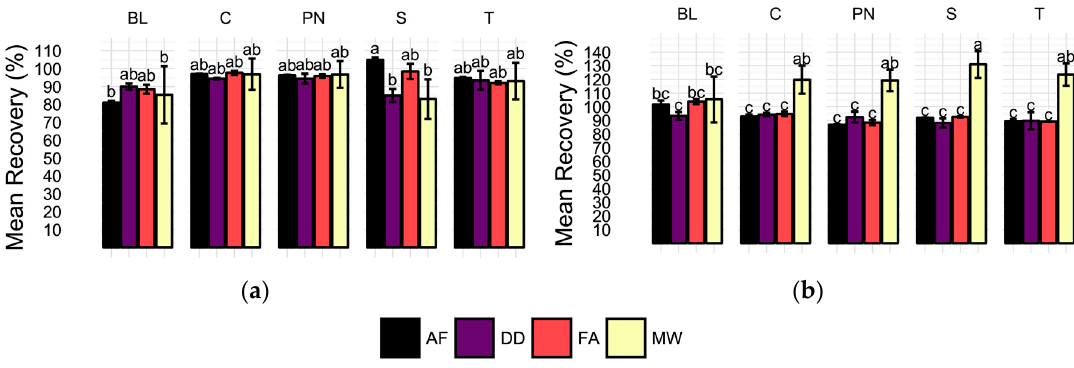
Figure 3. Average ( a ) 65 Cu and ( b ) 206 Pb spike recoveries (%) for each sample type (BL = method blank, C = Chardonnay, PN = Pinot noir, S = Syrah, T =Tempranillo) and preparation method (AF = acidification prior to filtration, DD = direct dilution, FA = filtration prior to acidification, MW = microwave-assisted digestion). Error bars represent one standard deviation. Means not sharing a letter (a, b, c) are significantly different by Tukey’s HSD’s. Recoveries calculated as the difference of concentration in the spiked sample and average unspiked sample concentration divided by the spike level, expressed as percentage.